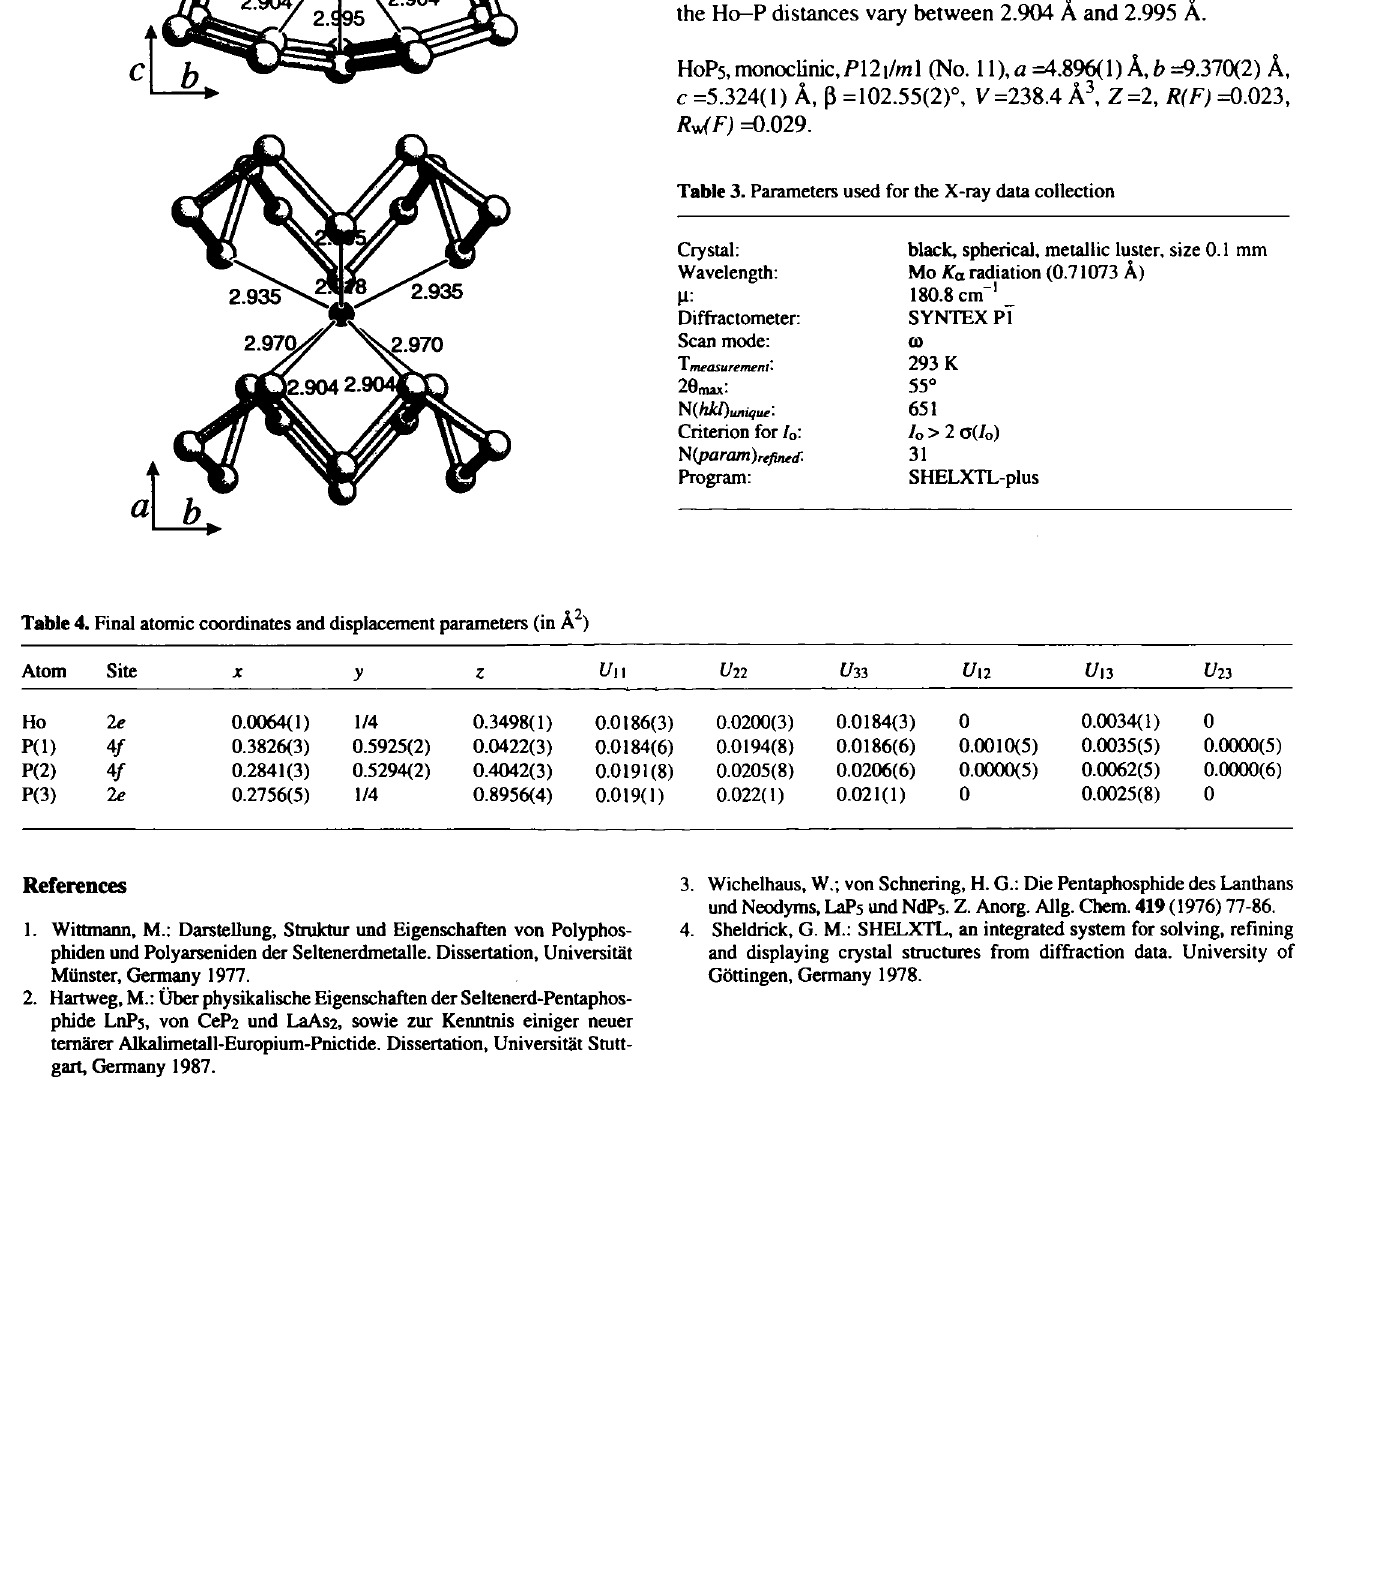
Table 3. Parameters used for the X-ray data collection Crystal: